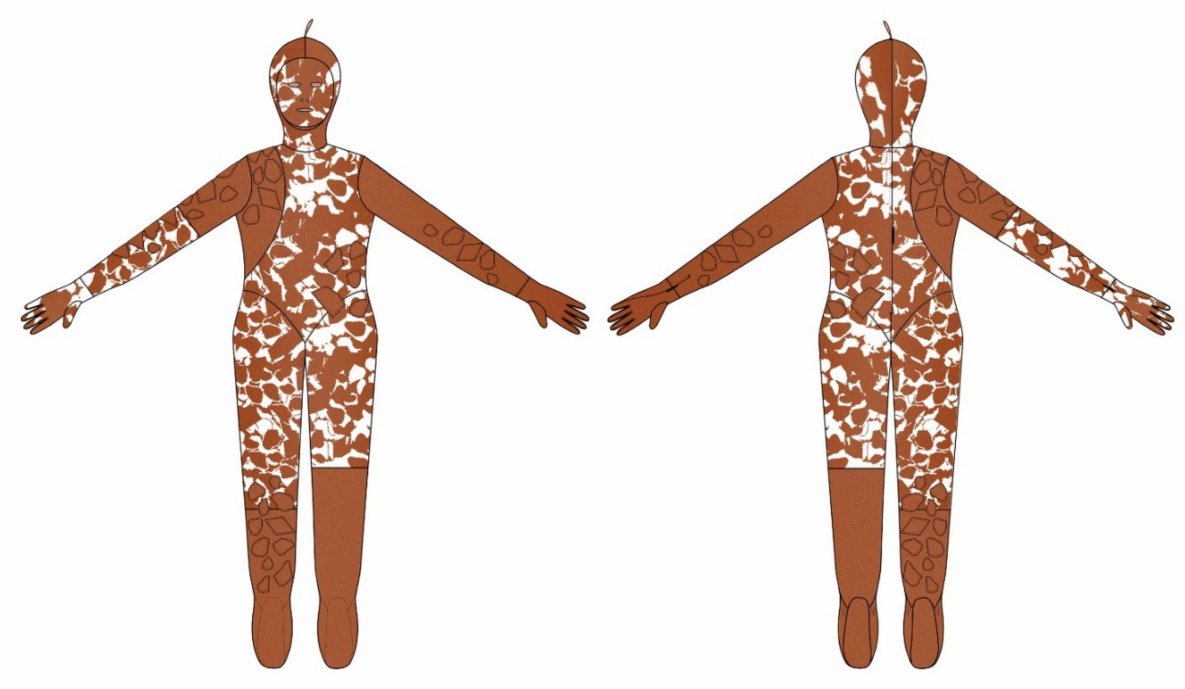
Figure 14. Technical drawing illustrated of the diurnal thermal camouflage